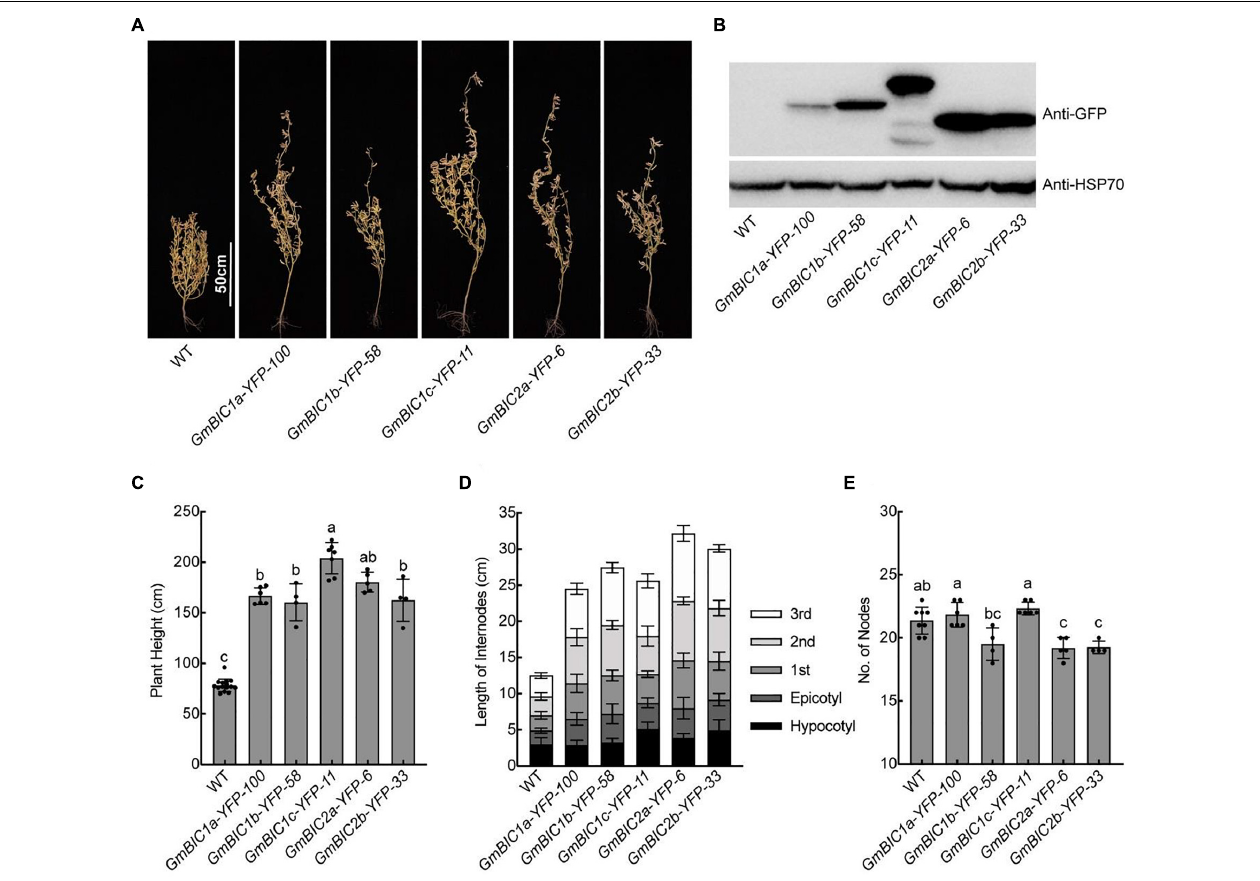
FIGURE 3 | Plant height phenotypes of the GmBICs-OX lines in field. (A) Representative images of indicated lines at the maturation stage grown in the Beijing field in 2020. Homozygous overexpression lines at T4 or higher generation were used. Scale bars = 50 cm. (B) Immunoblots of the GmBIC-YFP fusion proteins of each line as in (A) probed with the anti-GFP antibodies. HSP70 proteins were used as the loading control. Statistical analysis of the plant height (C) , the internodes length (D) , and the nodes number (E) of each line as in (A) . Data are means ± SD ( n ≥ 4). Lowercase letters indicate significant differences ( p < 0.01, One-way ANOVA with Tukey’s multiple comparisons